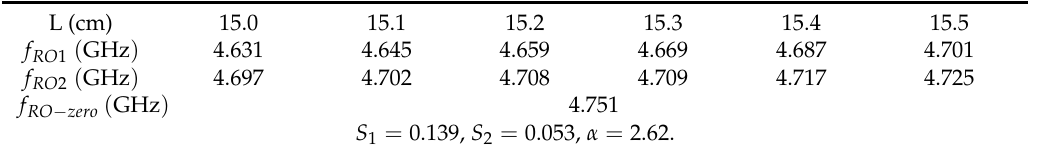
Table 4. Experimental